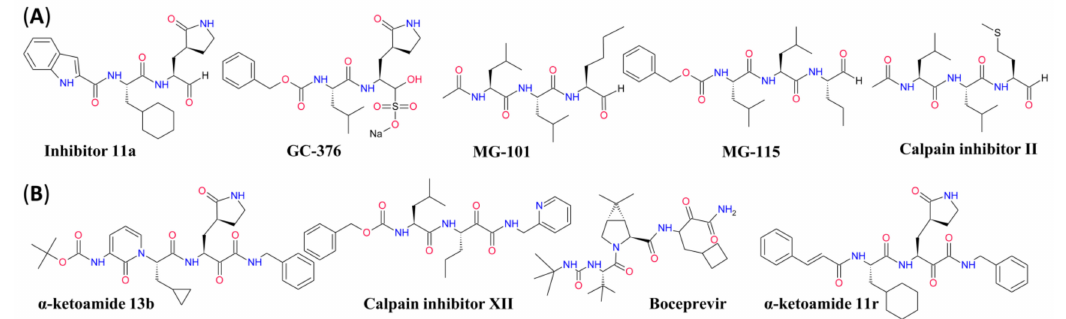
Figure A1. Structure of selected peptidomimetic SARS-CoV-2 Mpro inhibitors with electrophilic aldehyde ( A ) or α -ketoamide ( B ) warhead. For mechanism of action and pharmacological properties see Figure 5 and Table 2 in the main